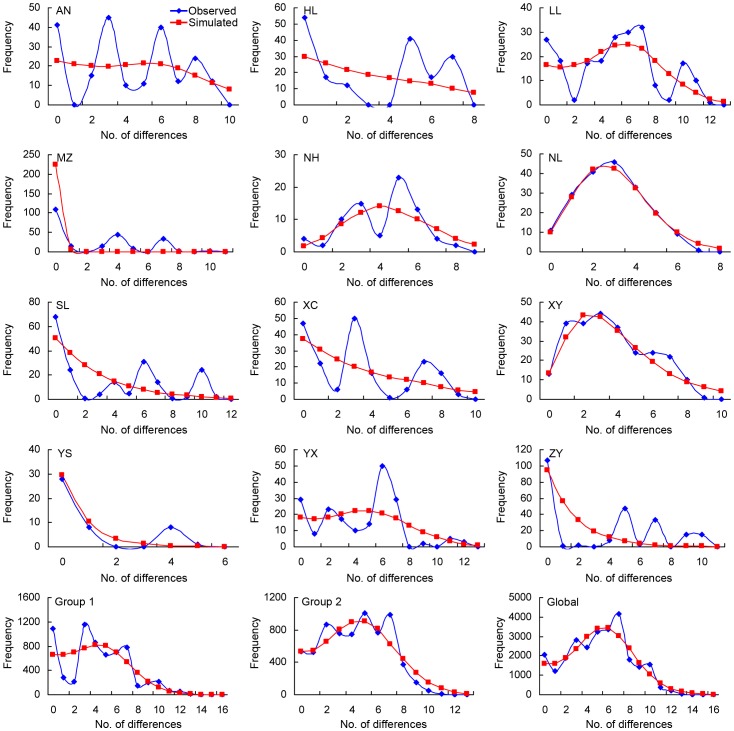
The mismatch distribution of the 12 populations of T. yunnanensis, the populations in Group 1, the populations in Group 2, and the global dataset.The blue lines indicated observed mismatch and the red lines indicated the simulation.